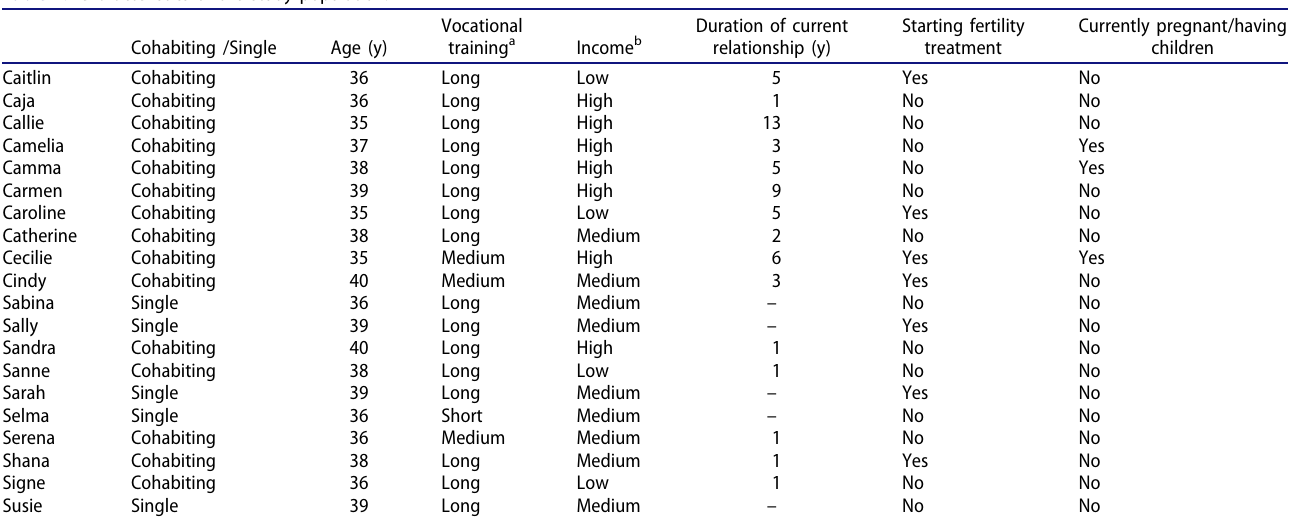
Table 2. Characteristics of the study population.